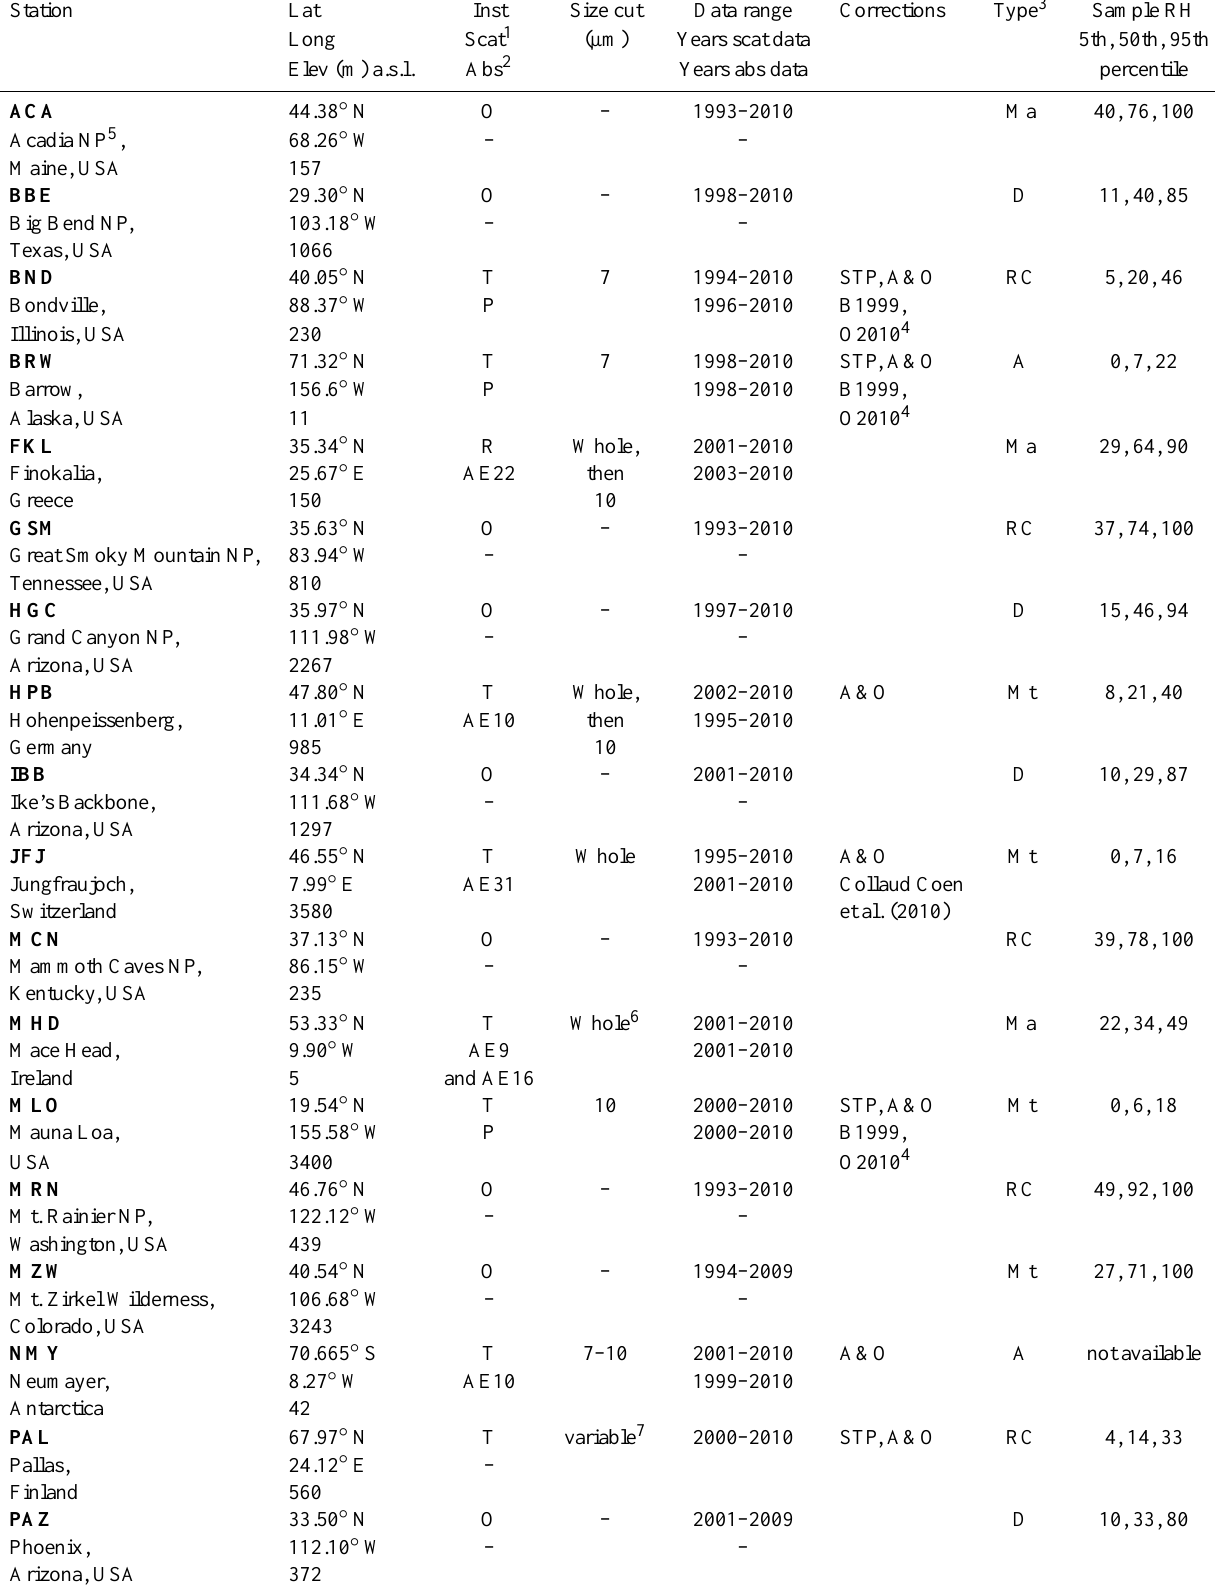
Table 1. List of observatories included in this study, arranged alphabetically (Data range years are inclusive).